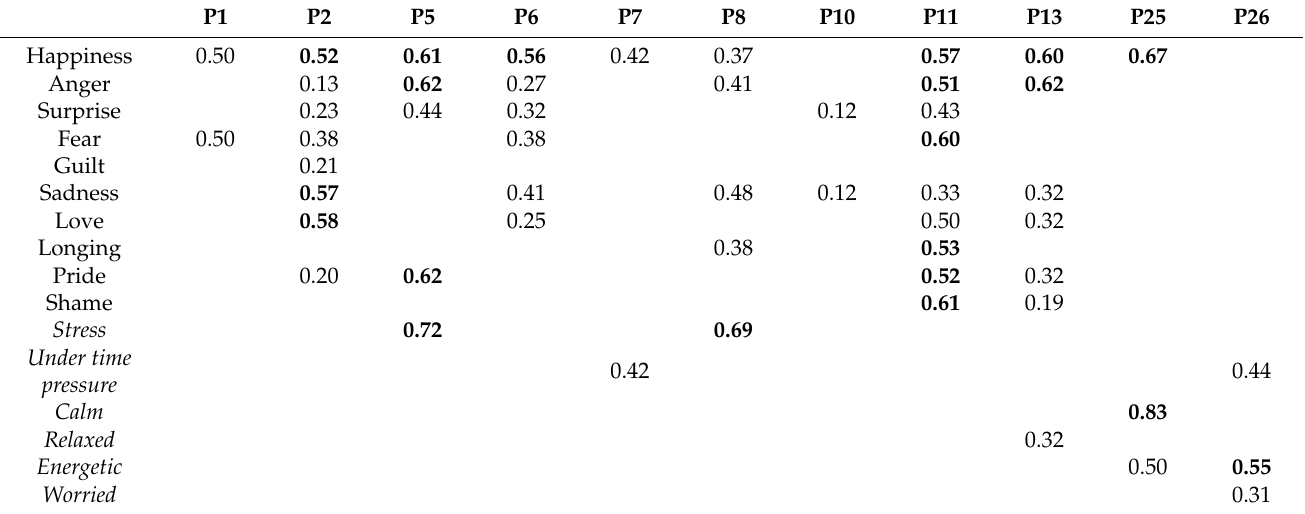
Table 4. AUROC evaluation of the emotion classification. For each participant (P1–P26), every labelled emotion is considered as positive class. AUROCs larger than 0.50, marked in bold, indicate that the emotion can better be differentiated from the other emotions than a random classifier would do. The emotions in italics are the emotions that were not asked to be labelled but were added on initiative of the participants